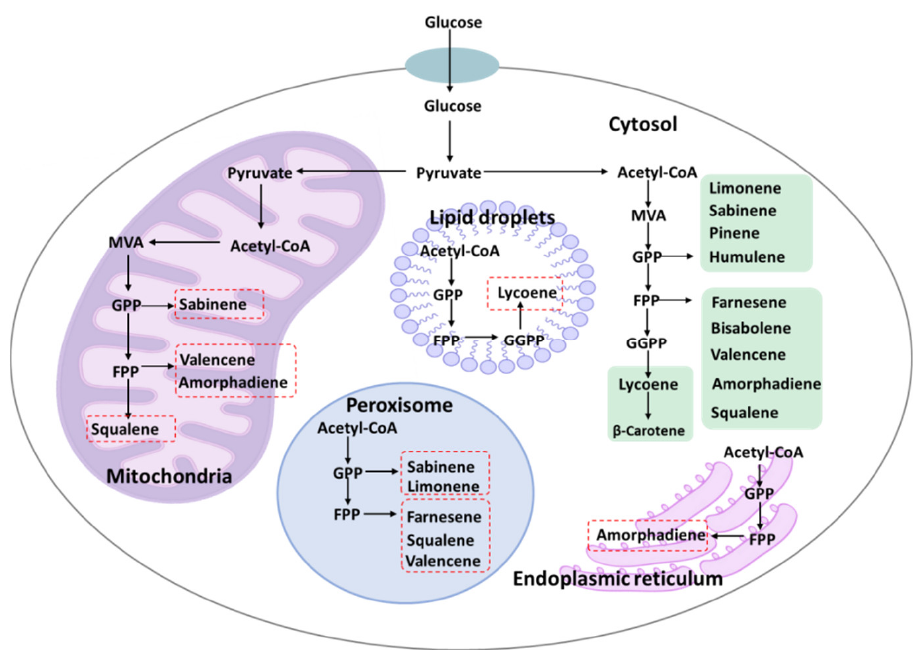
Figure 2. The introduction of terpene biosynthesis pathways into different organelles using the intracellular compartmentalized expression strategy. The red box represents the terpenes that can currently be synthesized in organelles. MVA, mevalonate; GPP, geranyl diphosphate; FPP, farnesyl diphosphate; GGPP, geranylgeranyl diphosphate.